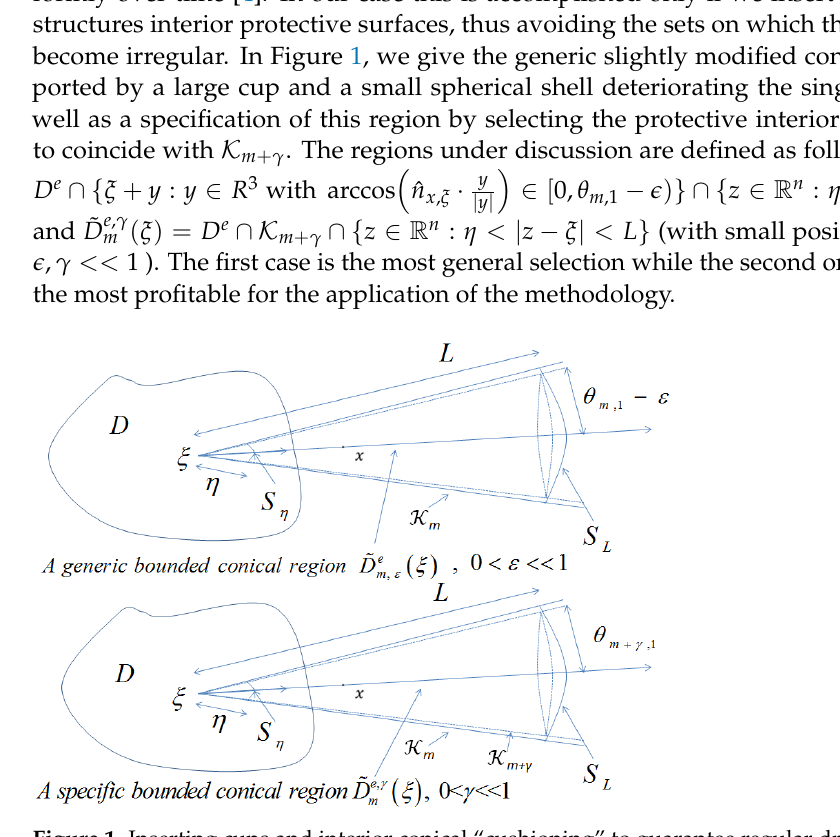
Figure 1. Inserting cups and interior conical “cushioning” to guarantee regular driving